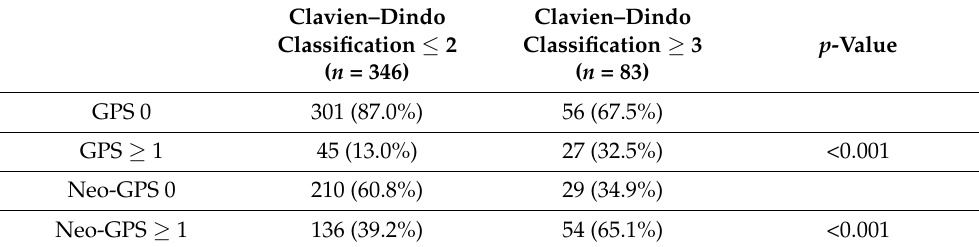
Table 3. Correlation between Clavien–Dindo classifications and elevated nutritional scoring.